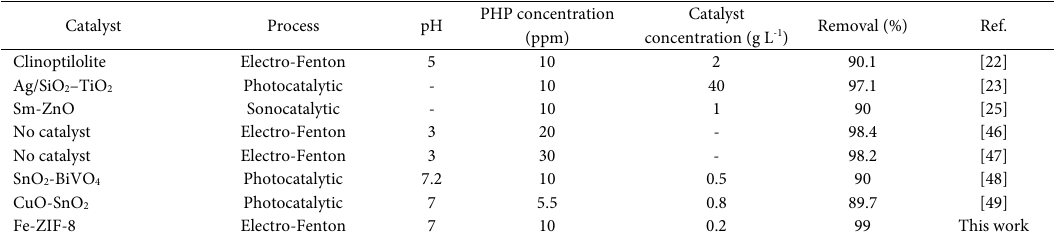
Catalyst Process pH